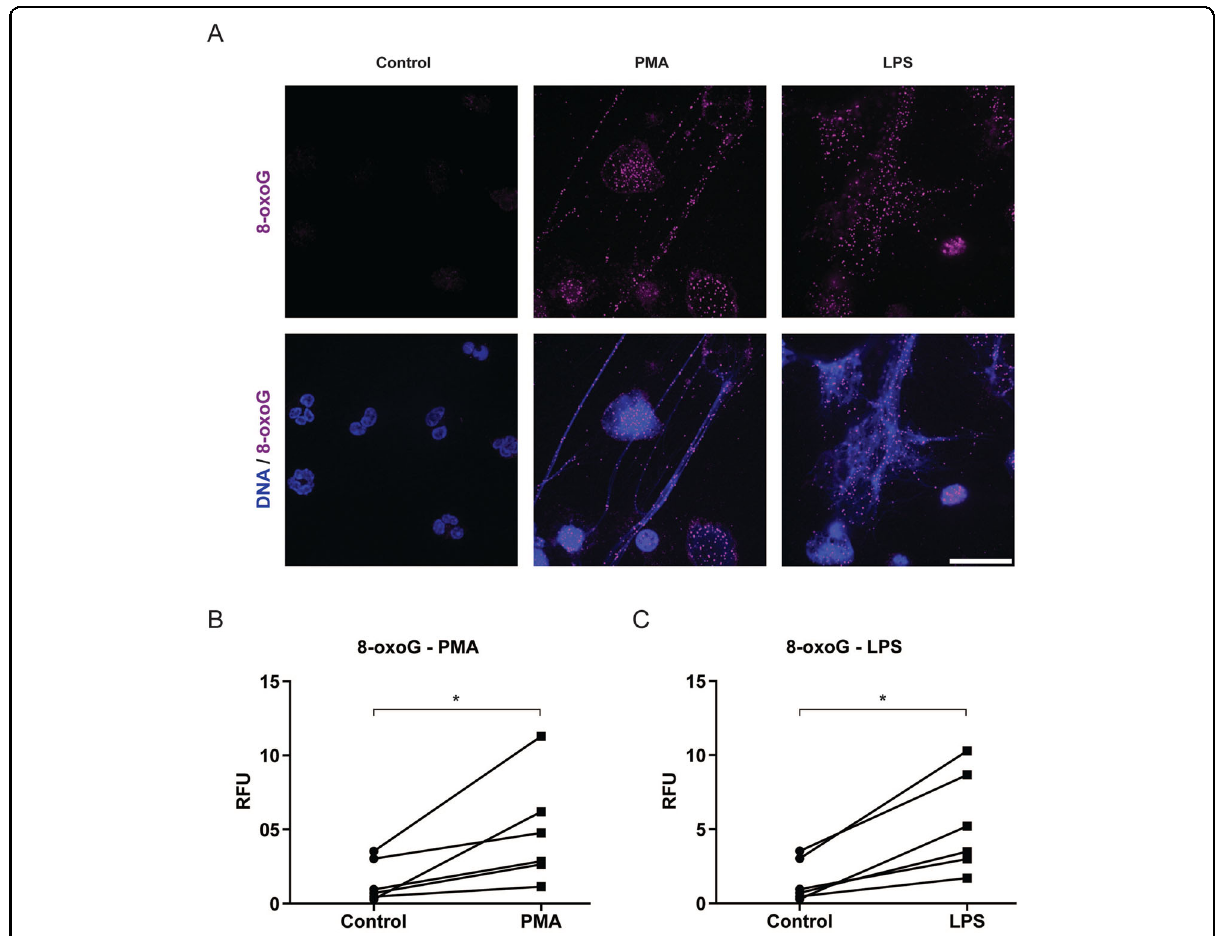
Fig. 1 PMA- and LPS-treated neutrophils generate increased levels of 8-oxoG. A Neutrophils were treated with PMA (25 nM) or LPS (5 μ g/ml) and incubated for 240 min. Cells were stained for DNA (DAPI, blue) and 8-oxoG (purple). The images are representative of three independent experiments. Scale bar, 10 μ m. B-C 8-oxoG levels following treatment with media (-ve control), PMA (25 nM) or LPS (5 μ g/ml) were measured using an in-cell ELISA. LPS- and PMA-treated cells had signi fi cantly greater 8-oxoG levels compared to media treated cells ( n = 6; * p <